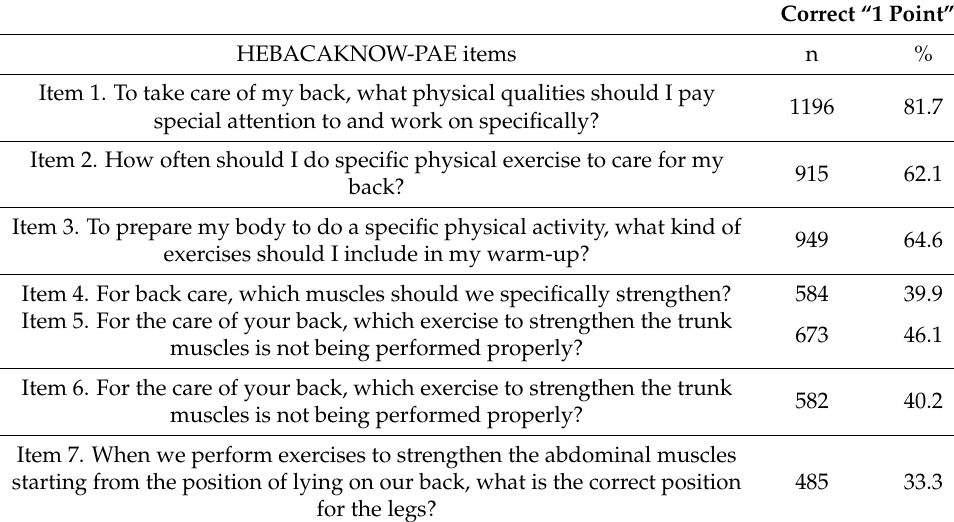
Table 5. Summary of the scores obtained for each HEBACAKNOW-PAE